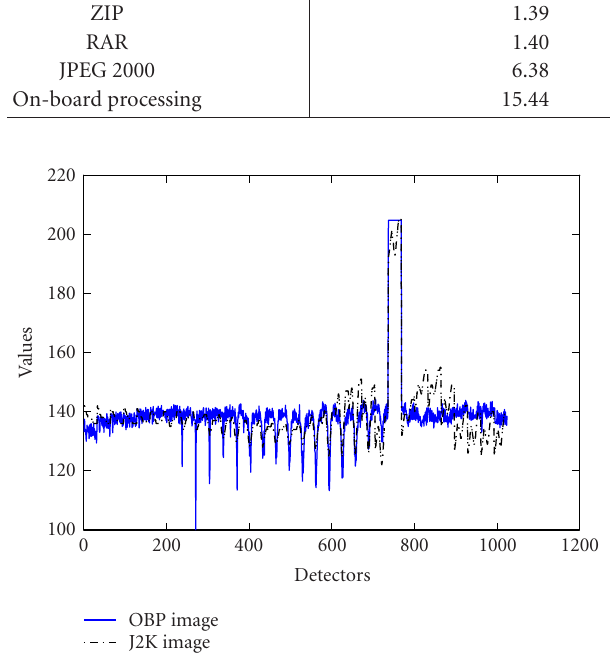
Figure 6: Illustration of the JPEG 2000 compressed image (dashed- dotted line) and the resulted image from on-board processing (solid line) on a 1D